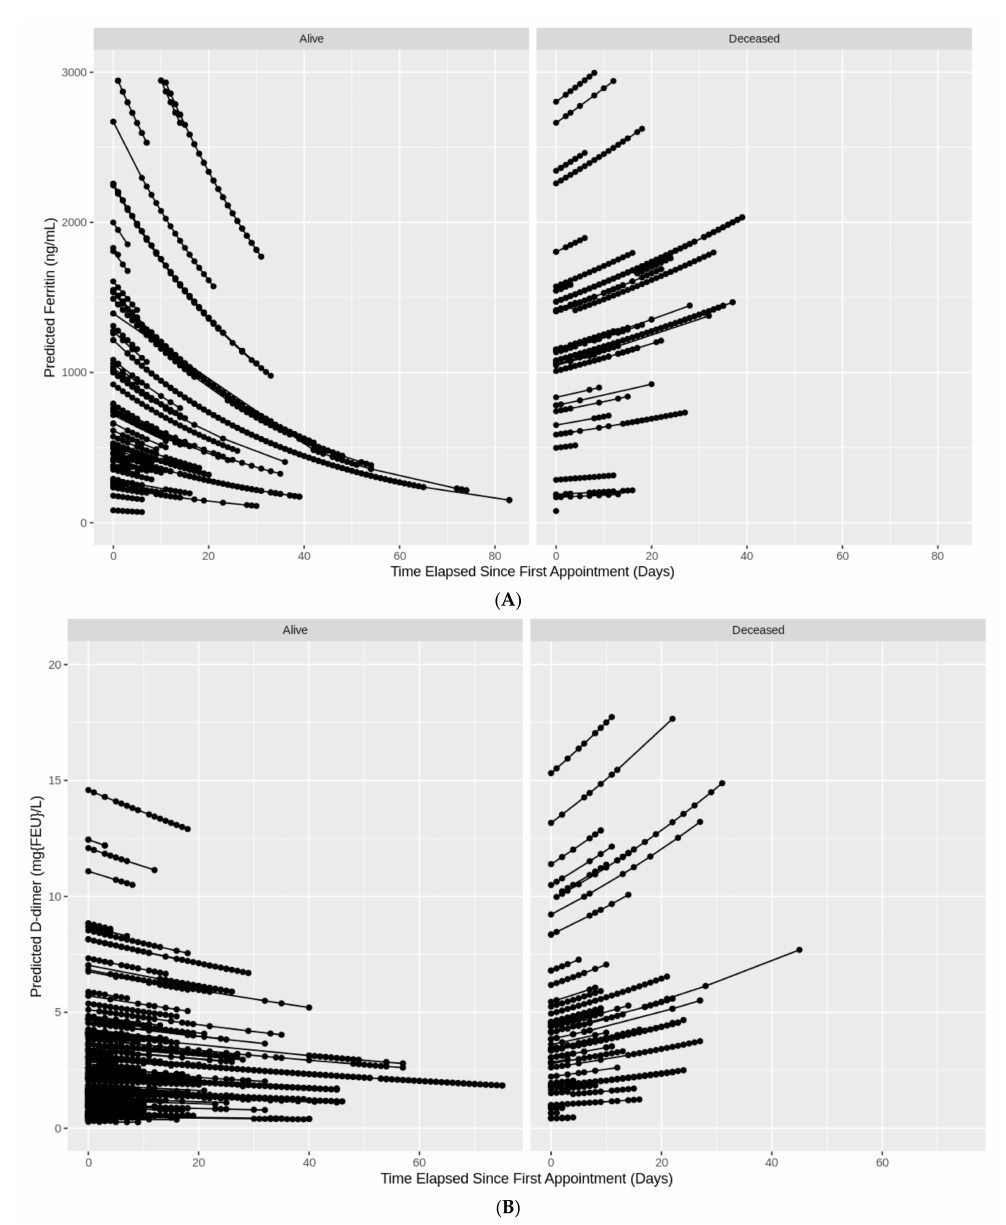
Figure 2. ( A ) Individual trajectories of ferritin levels over time in COVID-19 patients by death status. ( B ) Individual trajectories of D-dimer levels over time in COVID-19 patients by death